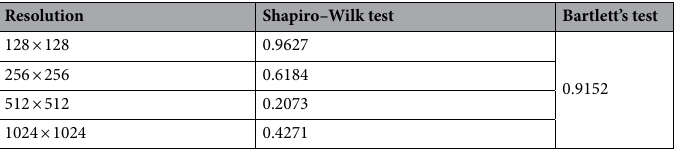
Table 1. Check of normality of each answer of d prime with the Shapiro–Wilk test and the check of equal variances with Bartlett’s test. All p-values were more than 0.05, which indicated that all answers were considered to have normal distribution and equal variances.